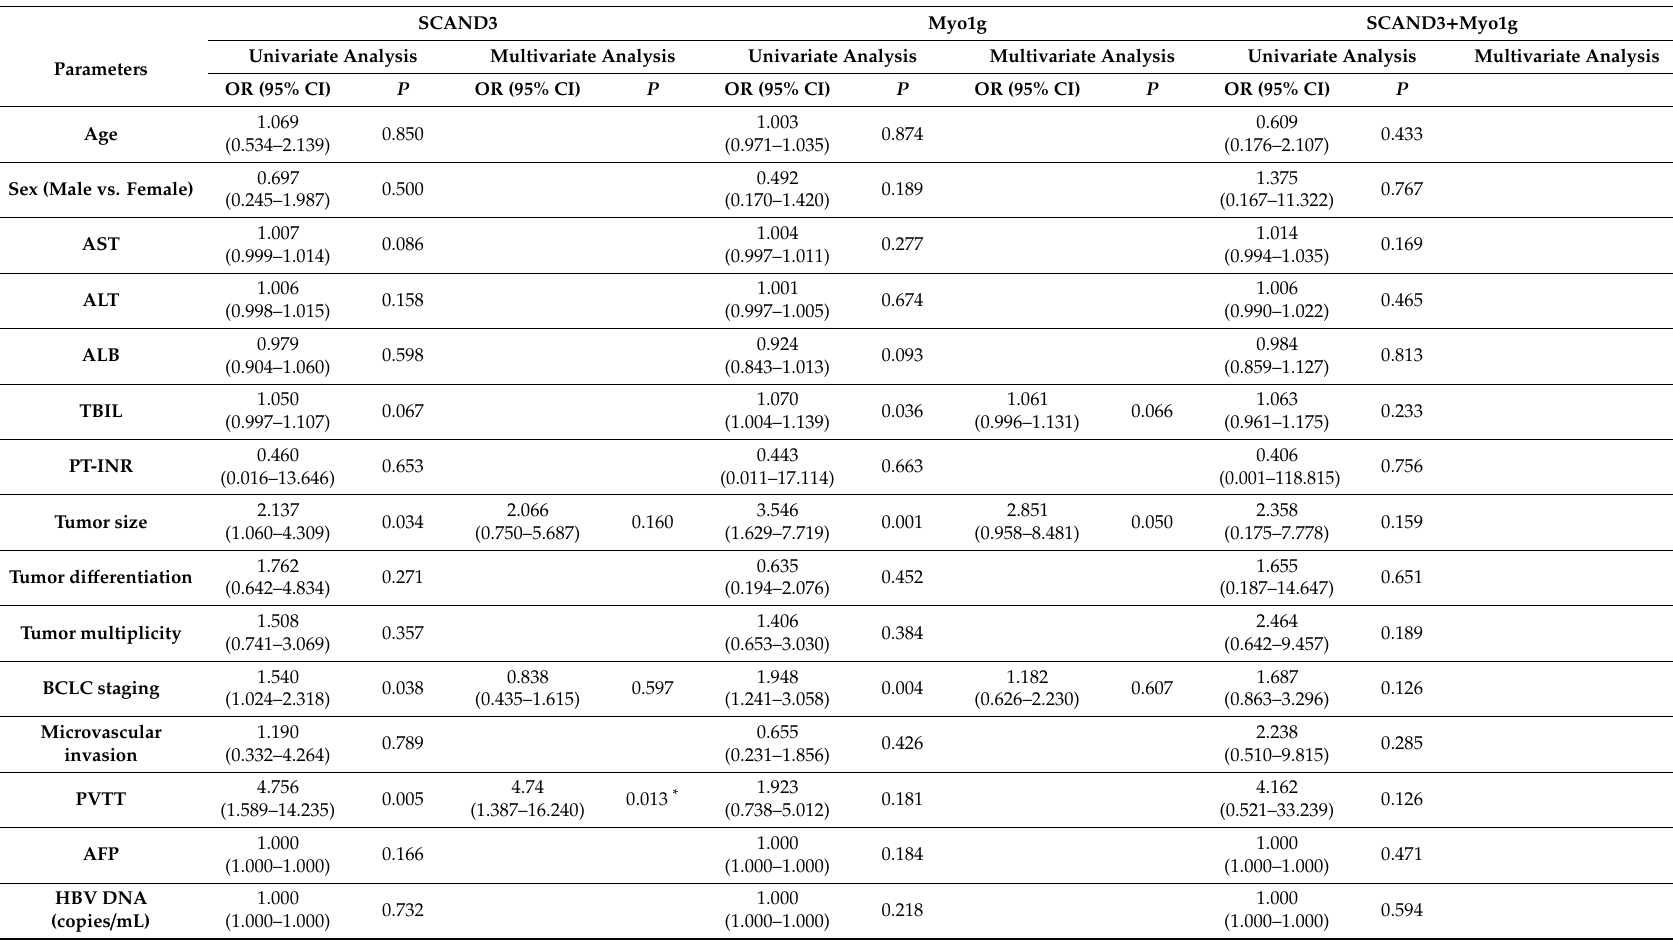
Table 5. Multivariate logistic regression analysis of the clinicopathological characteristics of serum gene methylation markers in